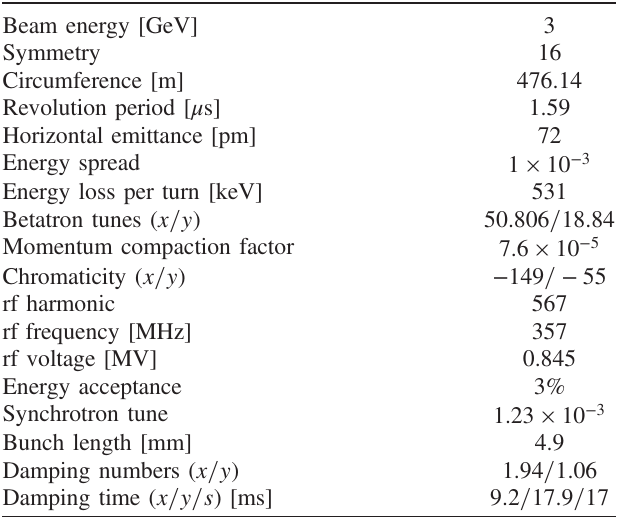
TABLE IV. Main parameters of SKIF lattice from Fig. 14.